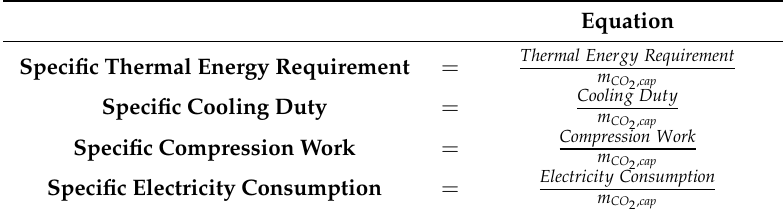
Table 2. Energy analysis: Performance indicators for carbon capture, utilization, and storage